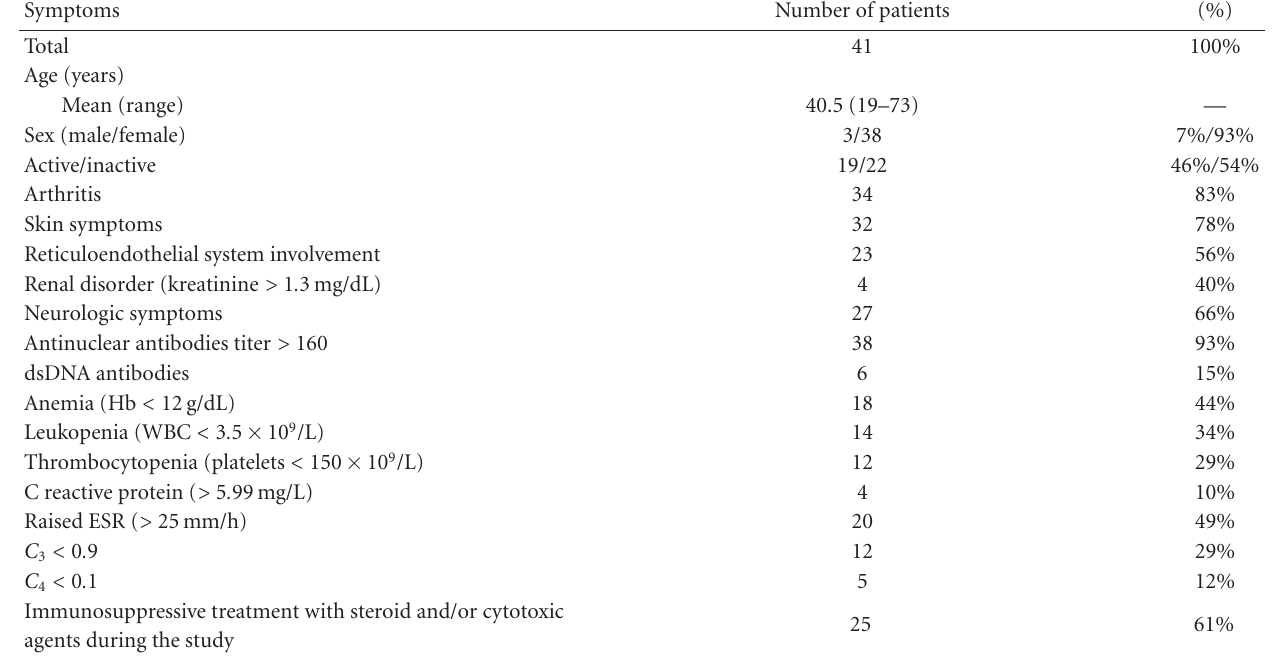
Table 1: Clinical and laboratory characteristics of SLE